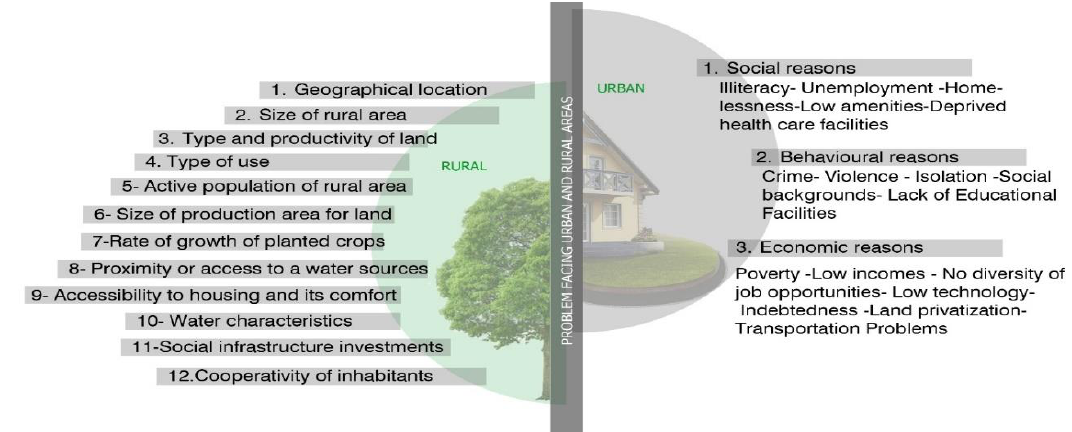
Figure 3 Challenges facing rural and urban regeneration Sources: modified by researchers from ((Yilmaz et al., 2010) , (Donnison, 1993) and (Nassar et al.,